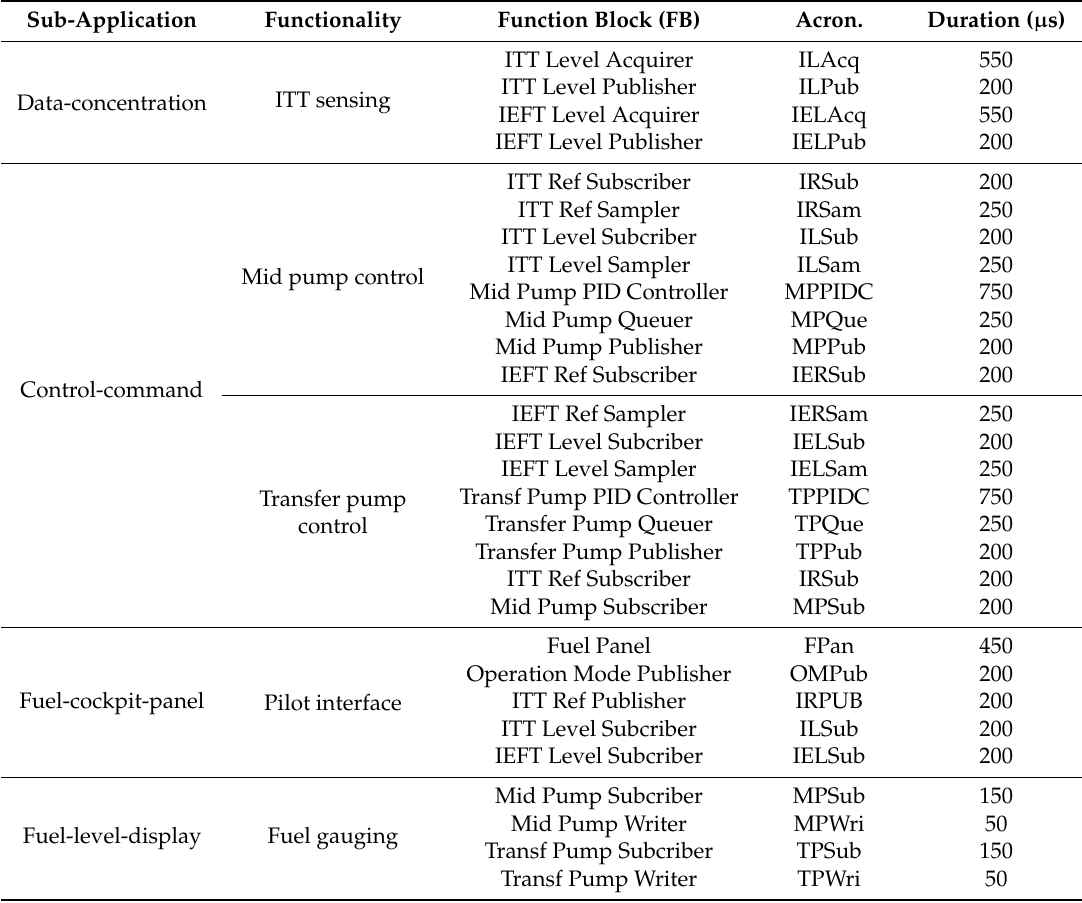
Table A1. Function Blocks (FBs) of each